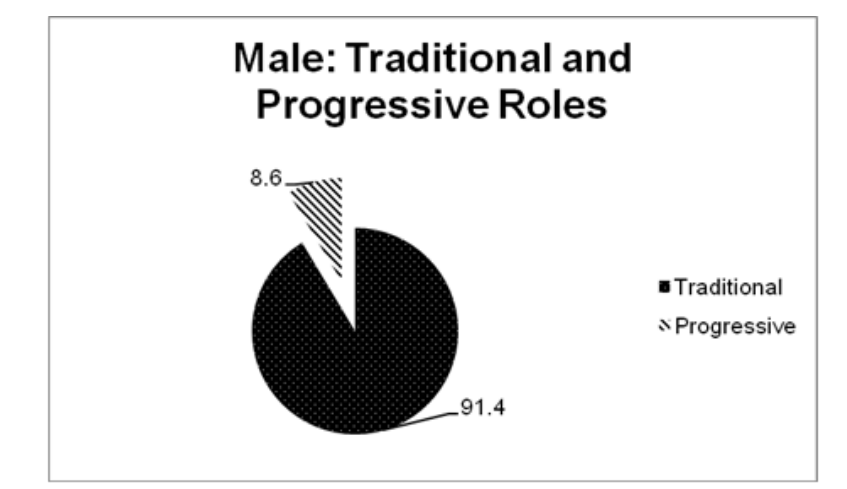
Ratio of traditional versus progressive roles males portray. Males have a clear traditional bias in their representation. Females have a closer balance between the portrayal of traditional and progressive roles: 52.5% of the identified traits are progressive (n=42) and 47.5% of the identified traits are traditional (n=38) (Figure 7). While this still leaves traditional roles as the majority, females are clearly being depicted more progressively than males. At 44.7% (n=17), independence is the highest-recorded progressive trait for females (Figure 8). The lowest occurring traditional roles displayed in Figure 9 are gentle (3.85%, n=2), helpless (3.85%, n=2), and timid/anxious (1.92%, n=1). The highest occurring traditional role is kind/thoughtful (31%, n=13), showing that females still retain a positive role while exhibiting independence, as opposed to increased signs of aggression (Figure 8). The ratio for female traditional roles versus female progressive roles is nearly balanced at 1:1 (Figure 7).